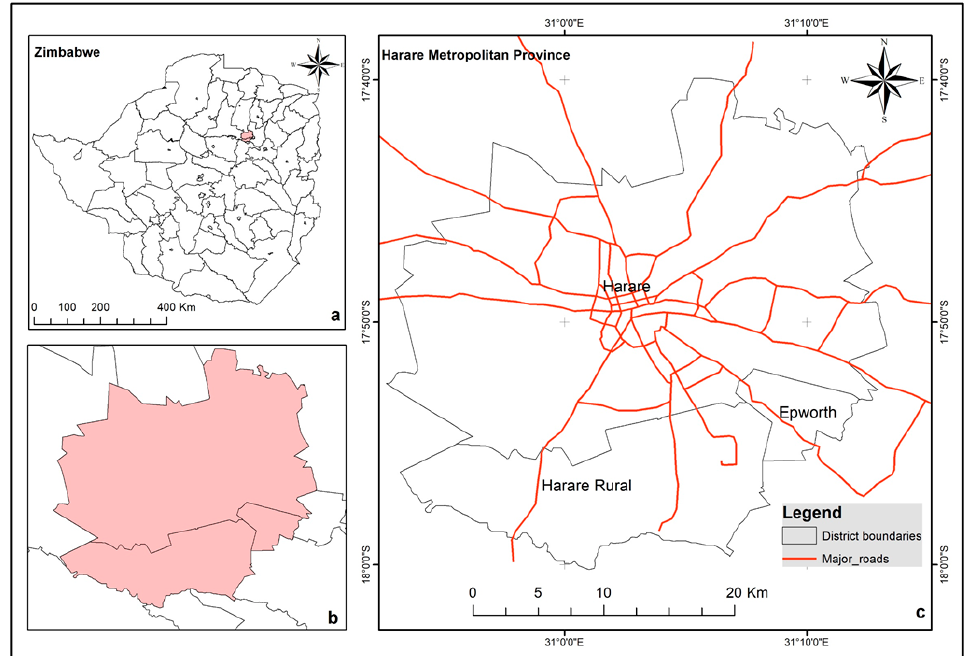
Figure 1. Location of the Harare Metropolitan Province composed of the Harare urban, Harare rural, and Epworth districts. ( a ) Zimbabwe district boundaries highlighting the study area; ( b ) Harare Metropolitan Province study boundaries; ( c ) major roads marked in the Harare Metropolitan Province map indicating the major urbanisation axis.